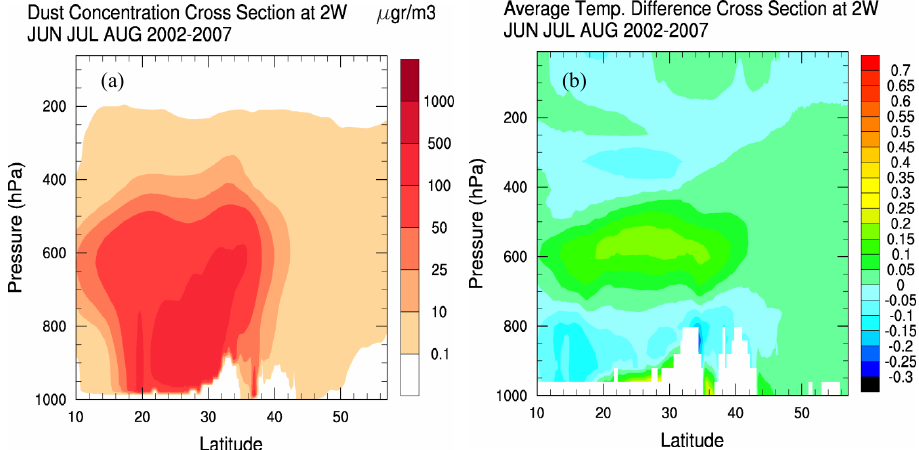
Fig. 14. Vertical cross-sections of (a) dust concentration at 2W and of (b) temperature difference at 2W (WDE – NDE), as averaged for the summer months of the 6-year period from the model simulations before and after incorporating dust–radiation interactions. The white color denotes the